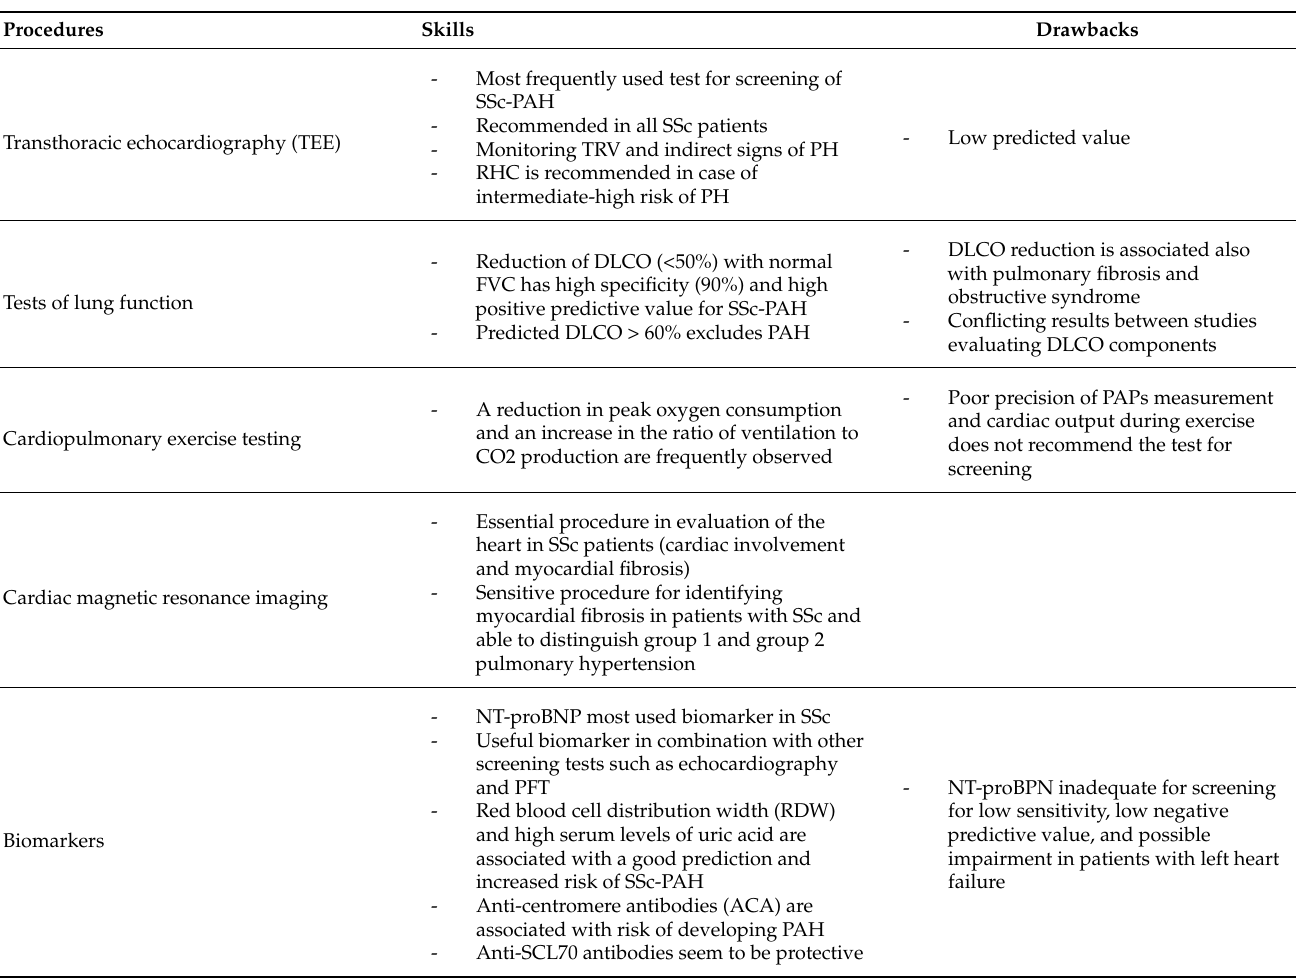
Table 2. Investigation tools to properly categorize different types of systemic sclerosis–pulmonary hypertension